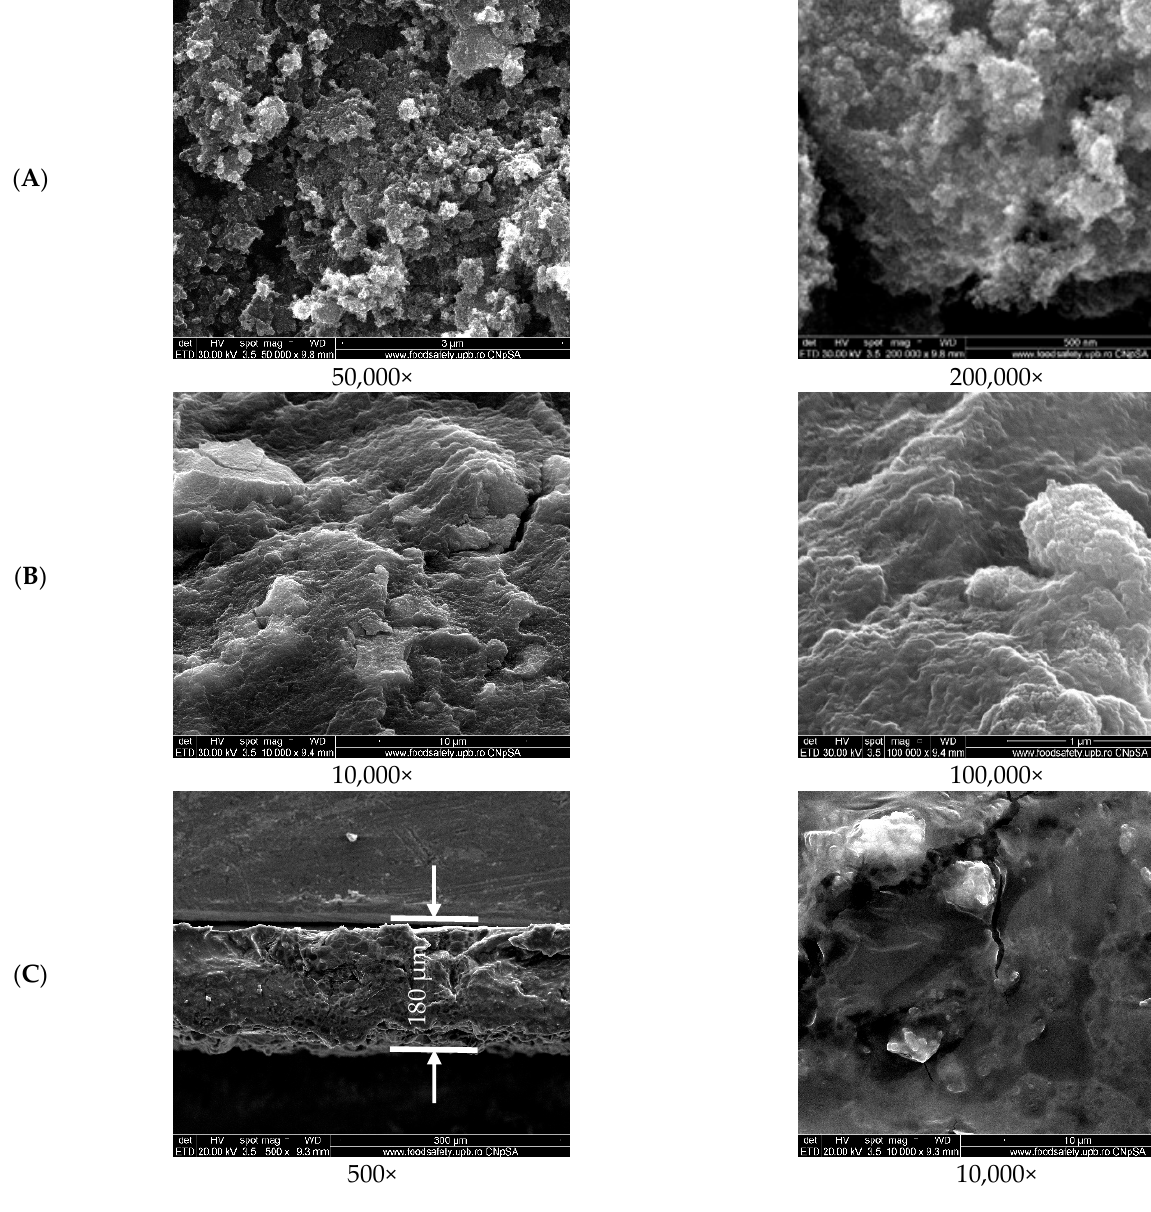
Figure 6. SEM images of magnetic nanoparticles ( A ), surface of magnetic alginate films ( B ), and cross-section of the magnetic alginate film ( C ) at different magnifications.